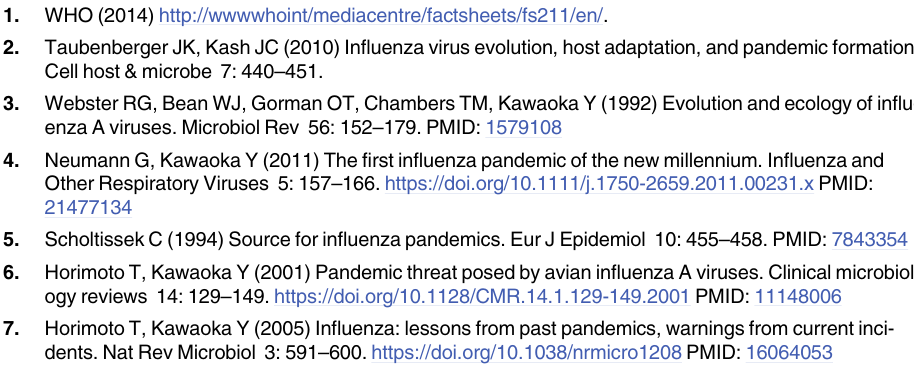
S3 Fig. Analysis of replication kinetics of H5N1 miRNA targeted viruses in ferret lung epi- thelial cells. Ferret cells were infected at an MOI = 0.001 and at various times post-infection supernatants were collected, and titers were determined by plaque assay on MDCK cells. Left– H5N1 viruses with an HA containing the multibasic cleavage site (High Path). Right–H5N1 viruses with an HA lacking the multibasic cleavage site (Low Path). (TIF) S4 Fig. Analysis of replication kinetics of low pathogenic H5N1 miRNA-targeted viruses. Human and mouse cell lines were infected at the indicated MOI and at various times post- infection supernatants were collected for viral titer determination. The titers are shown as PFU/mL (mean ± SEM). The limit of detection is 10 PFU/mL. The cell lines were infected at MOIs: A549 (0.001), THP-1 (0.01), HMVEC (0.01), LA-4 (1), J774 (0.01), and MS1 (1).